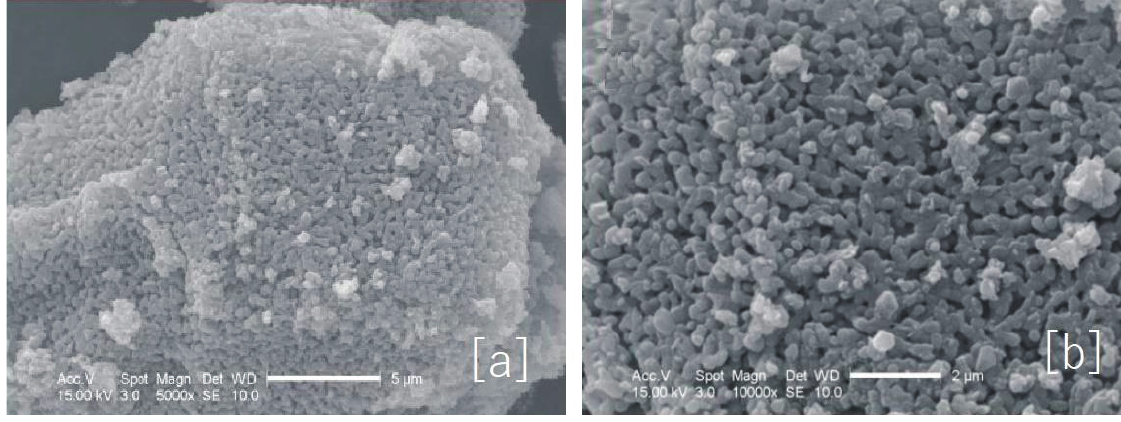
Table 3 – Correlation coefficients of the specific surface area and the activation temperatures in the sodium compounds SO and SOm